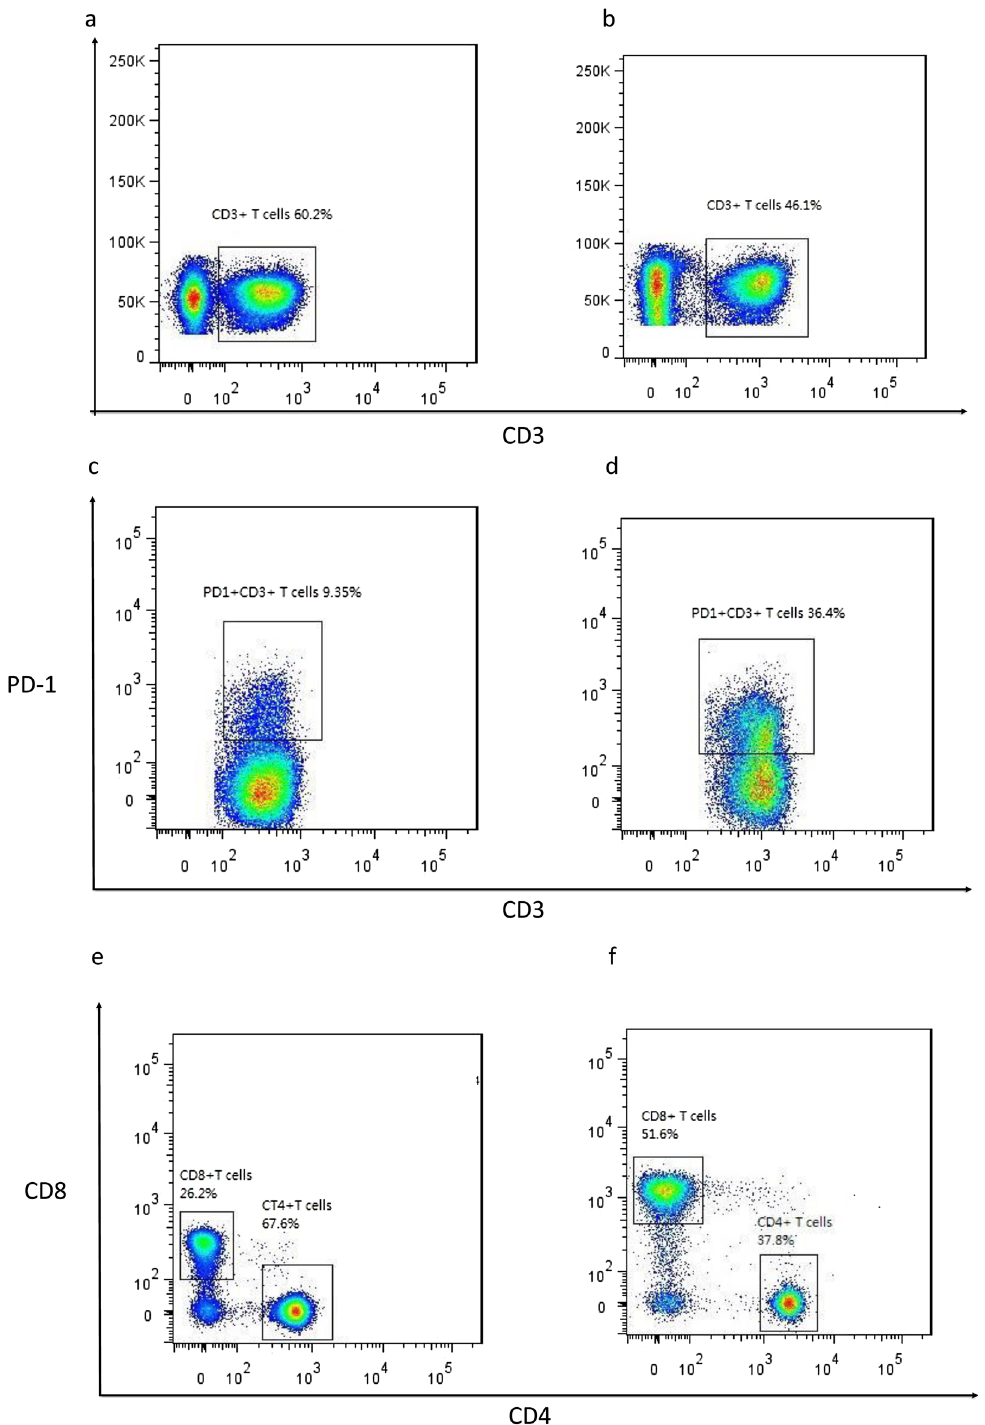
Figure 9. T cells and subpopulations in trauma patients. ( a,c,e ) T cells, PD-1 expression on T cells, CD4+ and CD8+ T cells in patients with short ICU stay. ( b,d,f ) T cells, PD-1 expression on T cells, CD4+ and CD8+ T cells in patients with long ICU